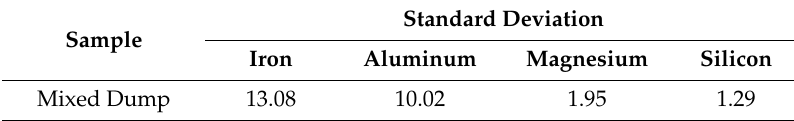
Table 7. Standard deviation reported for each set of ion extraction e ffi ciencies. Sample